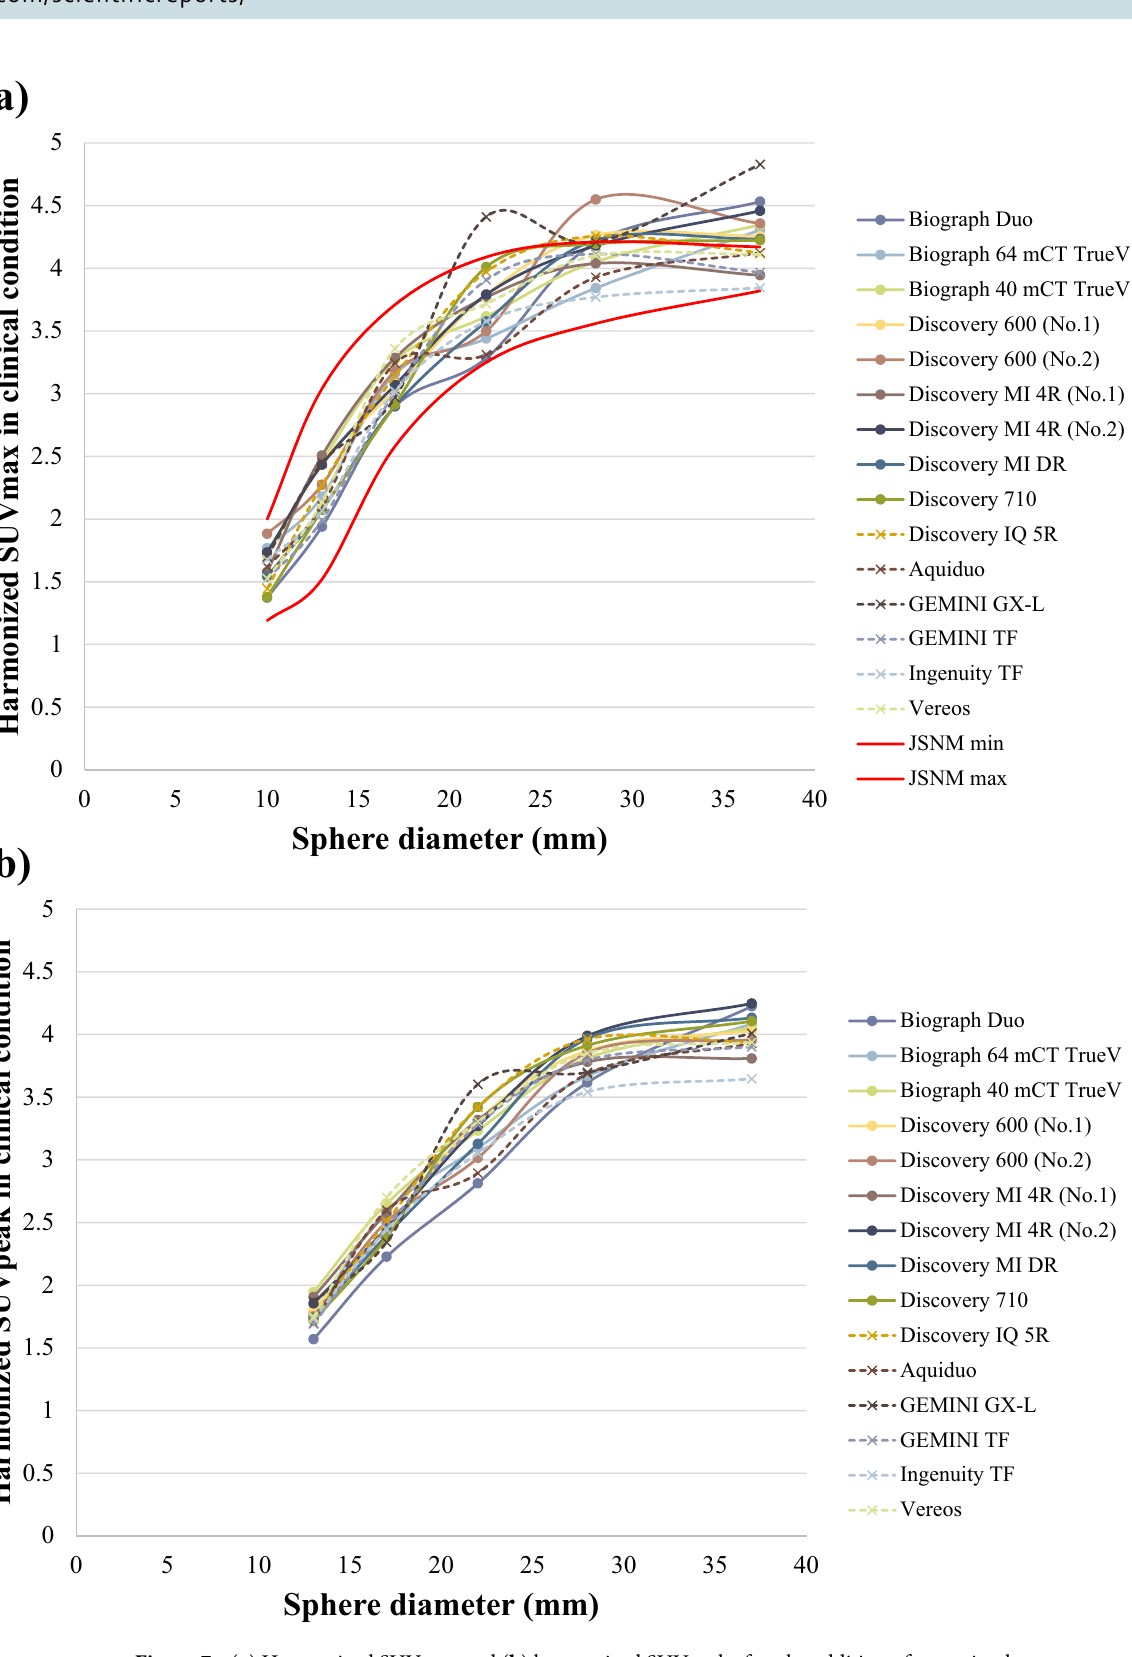
Figure 7. ( a ) Harmonized SUVmax and ( b ) harmonized SUVpeak after the addition of an optimal harmonization filter under clinical conditions. The harmonized SUVmax measured using PET images under clinical conditions exceeded the JSNM upper limits for the 22-mm, 28-mm, and 37-mm hot spheres on some scanners. The actual values obtained using each scanner are shown in Online Resource 5 (harmonized SUVmax) and Online Resource 6 (harmonized